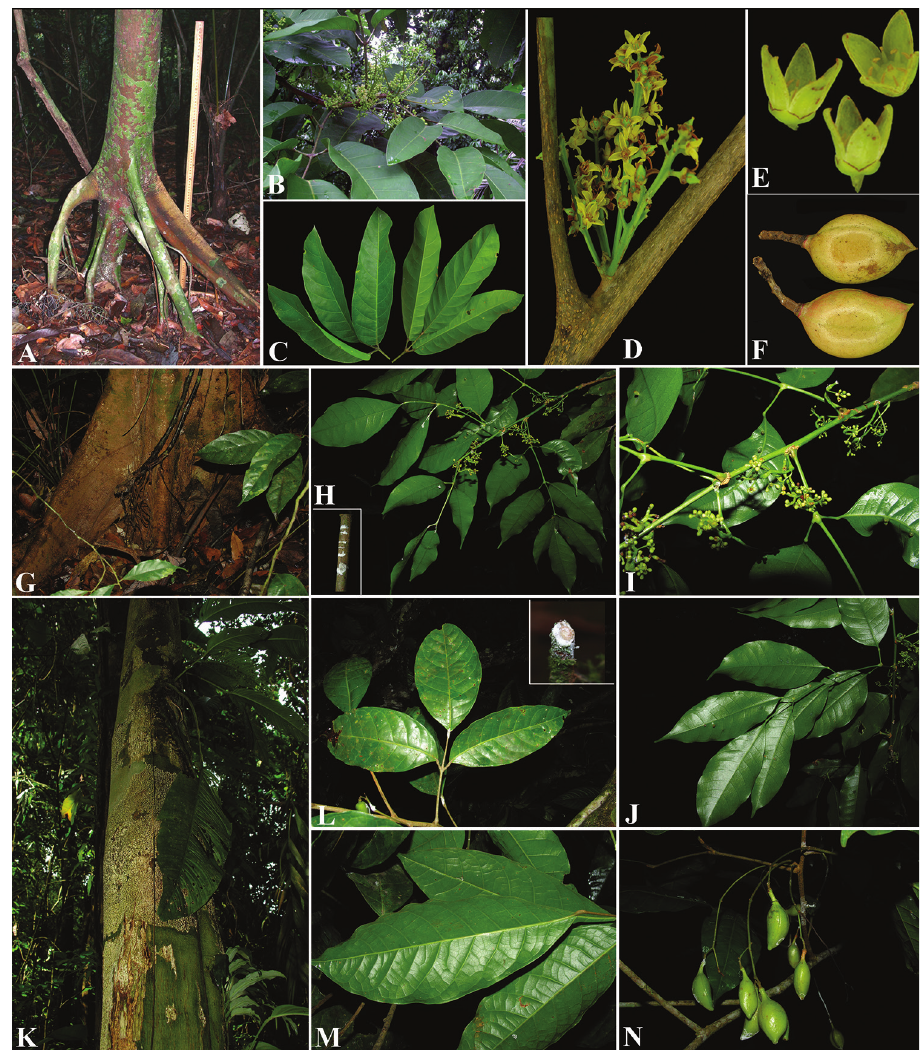
Figure 6. Protium panamense . A Stilt roots B Branch with inflorescences C Leaflets D Inflorescences E Staminate flowers F Fruits. Protium aracouchini G Trunk base H Branch with inflorescences; inset showing dry resin on cut twig I Inflorescences; also see the suberose petiole base J Abaxial side of the leaflets. Protium ravenii K Trunk L Adaxial side of the leaflets; inset dry resin on cut twig M Abaxial side of the leaflets N Fruits. Photo credits: Rolando Pérez ( A ); Carmen Galdames ( B ); Steven Paton ( C–F ). G–J photos by Reinaldo Aguilar, from D. Santamaría & R. Aguilar 9836 K–N photos by Reinaldo Agui- lar, from R. Aguilar 12067, except L , inset by Orlando